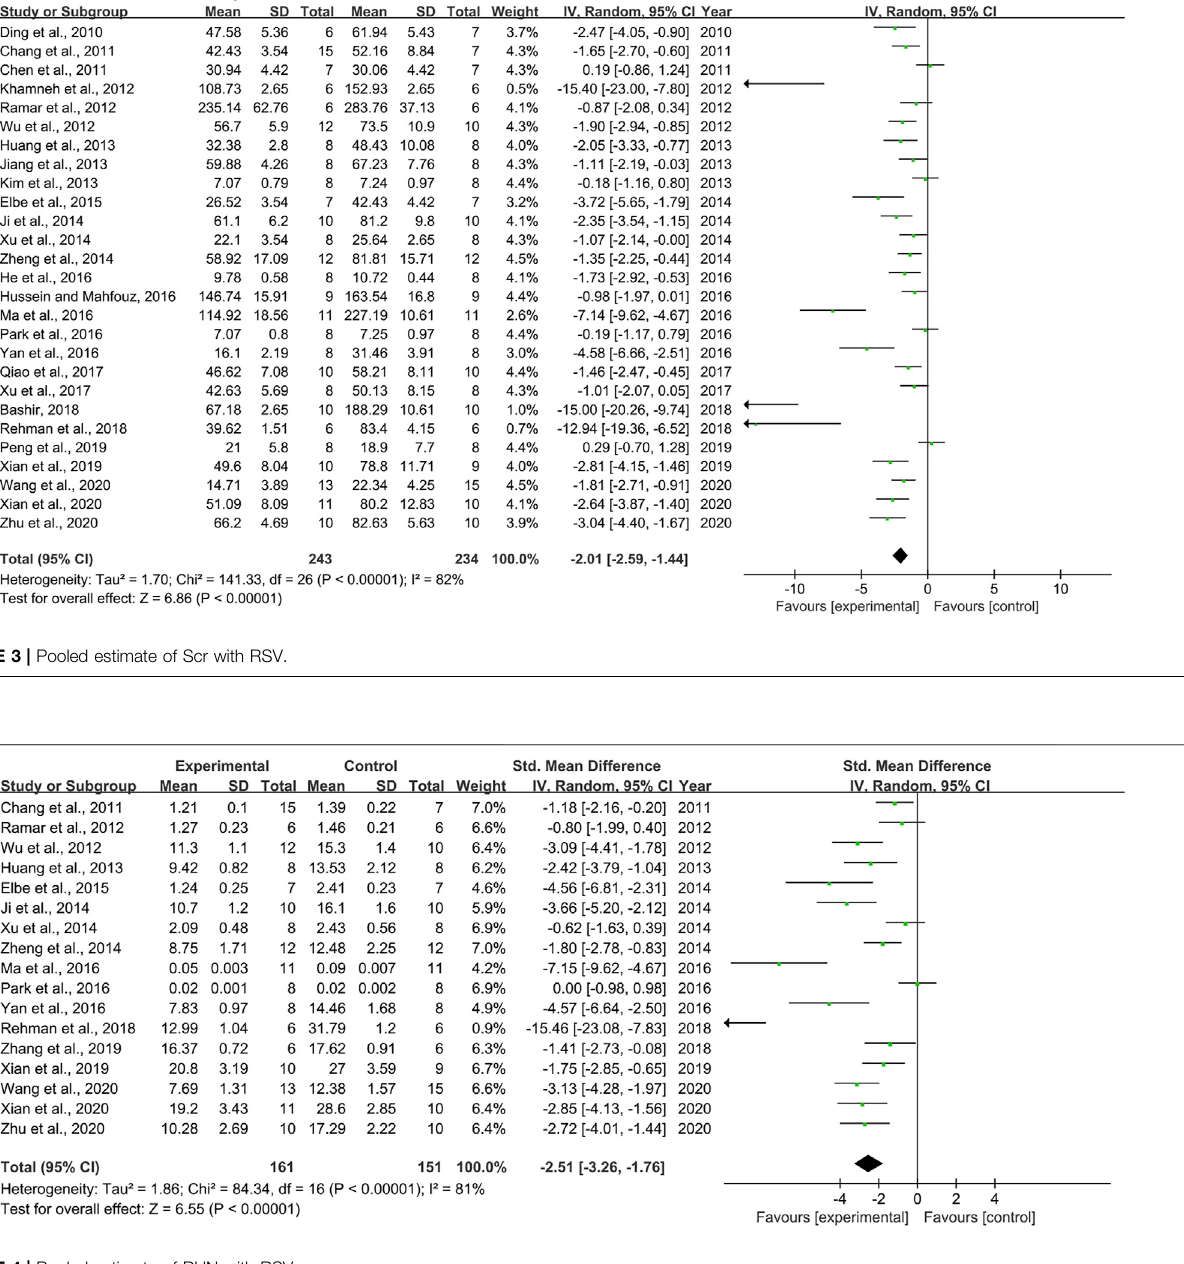
Figure 5 ]. Subgroup analysis was conducted based on DN